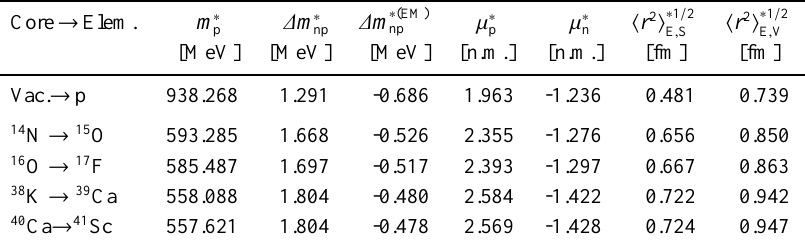
is the p p 1 / 2 r 2 and E , S h i ∗